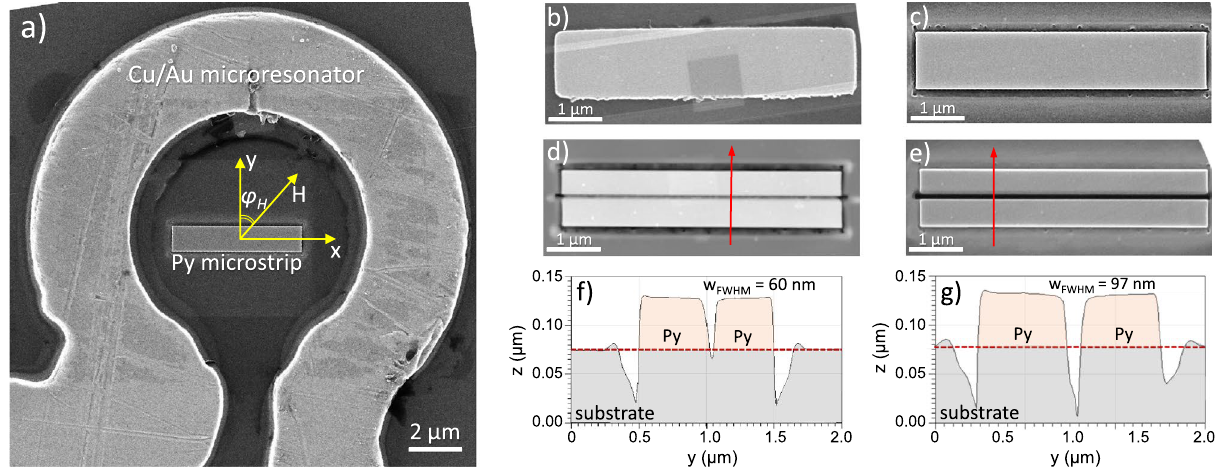
Figure 1. ( a ) Scanning electron microscopy (SEM) image of the (cid:31) -shaped Cu/Au microresonator loop and the 5 µ m × 1 µ m × 50 nm Py strip sample positioned in the center. During the µ FMR measurements, the static external magnetic field H is applied in-plane of the microstrip at angle φ H with respect to the short axis of the strip. ( b – e ) SEM images of the ( b ) as-prepared Py microstrip, ( c ) edge-trimmed using Ne-FIB, ( d ) cut along by Ne-FIB leaving a nominal gap of 50 nm and ( e ) 100 nm. ( f , g ) Atomic force microscopy (AFM) profiles of the cut strips measured along the red arrows shown in ( d ) and ( e ), respectively. Dashed lines indicates the substrate